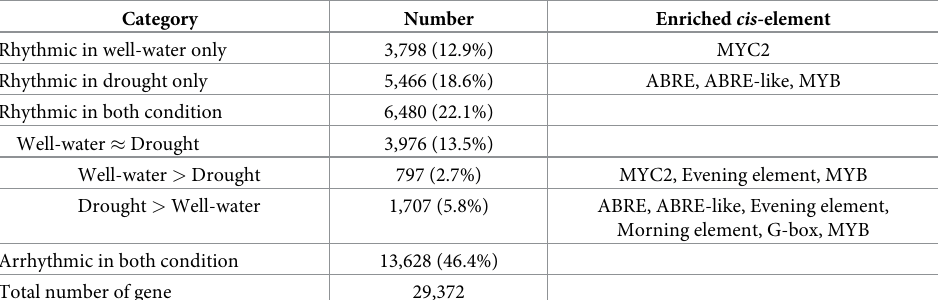
Table 1. Summary of gene circadian rhythm changes between well-watered (C3) and drought (CAM-cycling)